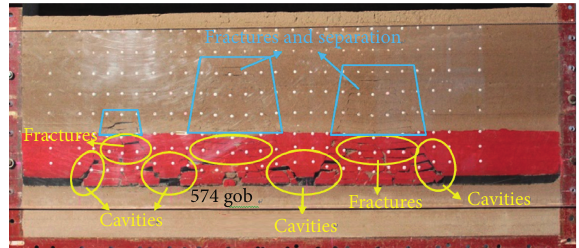
Figure 11: Cavities and fracture distribution of bedrock and loose layers after